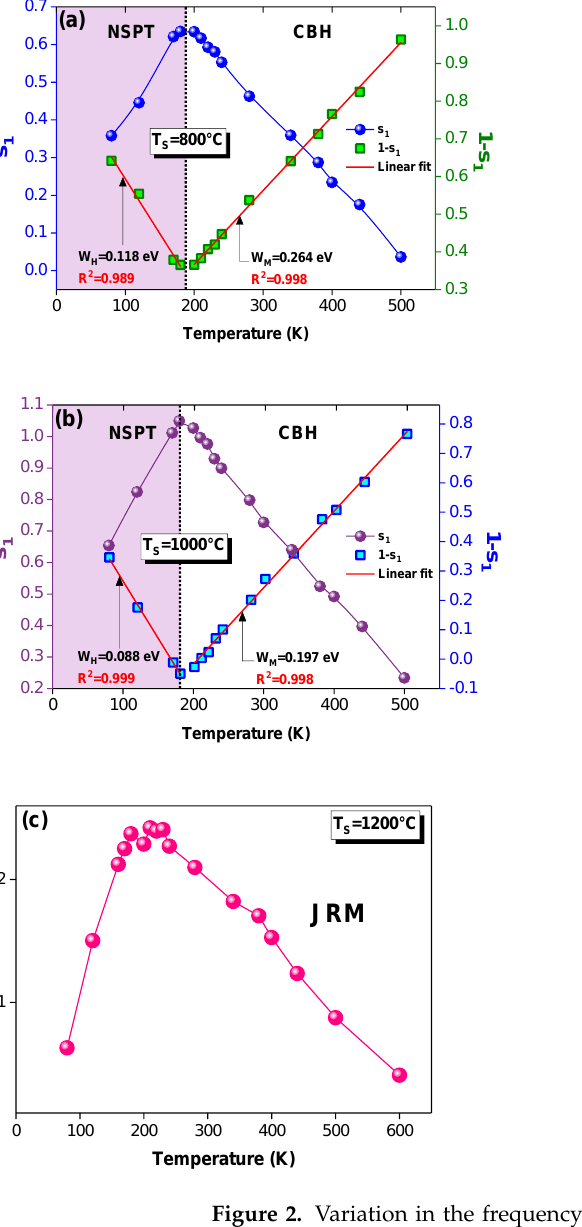
Figure 2. Variation in the frequency exponents ( a – c ) ‘s 1 ’ and ( d – f ) ‘s 2 ′ with temperature for the La0.9Sr0.1MnO 3 system sintered at ( a , d ) 800, ( b , e ) 1000 and ( c , f ) 1200 °C.